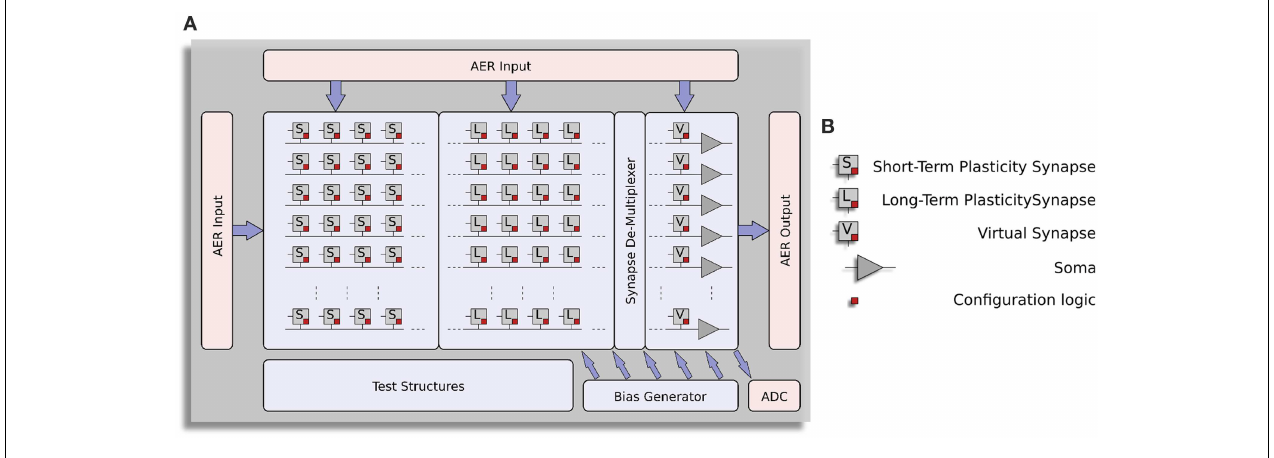
FIGURE 1 | Architecture of ROLLS neuromorphic processor. (A) Block diagram of the architecture, showing two distinct synapse arrays (short-term plasticity and long-term plasticity synapses), an additional row of synapses (virtual synapses) and a row of neurons (somas). A synapse de-multiplexer